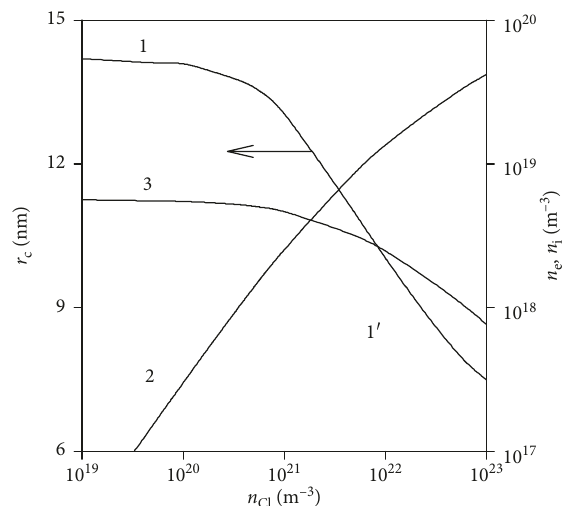
Figure 7: Dependences of the concentrations of electrons, chloride ions, and the radius of Al 2 O 3 particles in the microflame of an aluminum particle on the concentration of chlorine atoms ( C f 0.4kg/m 3 , T g 3200K. 1, the particle radius of Al 2 O 3 ( r c ); 2, (cid:31) (cid:31) the concentration of chloride ions ( n ); 3, the electron concen- Cl tration ( n e −